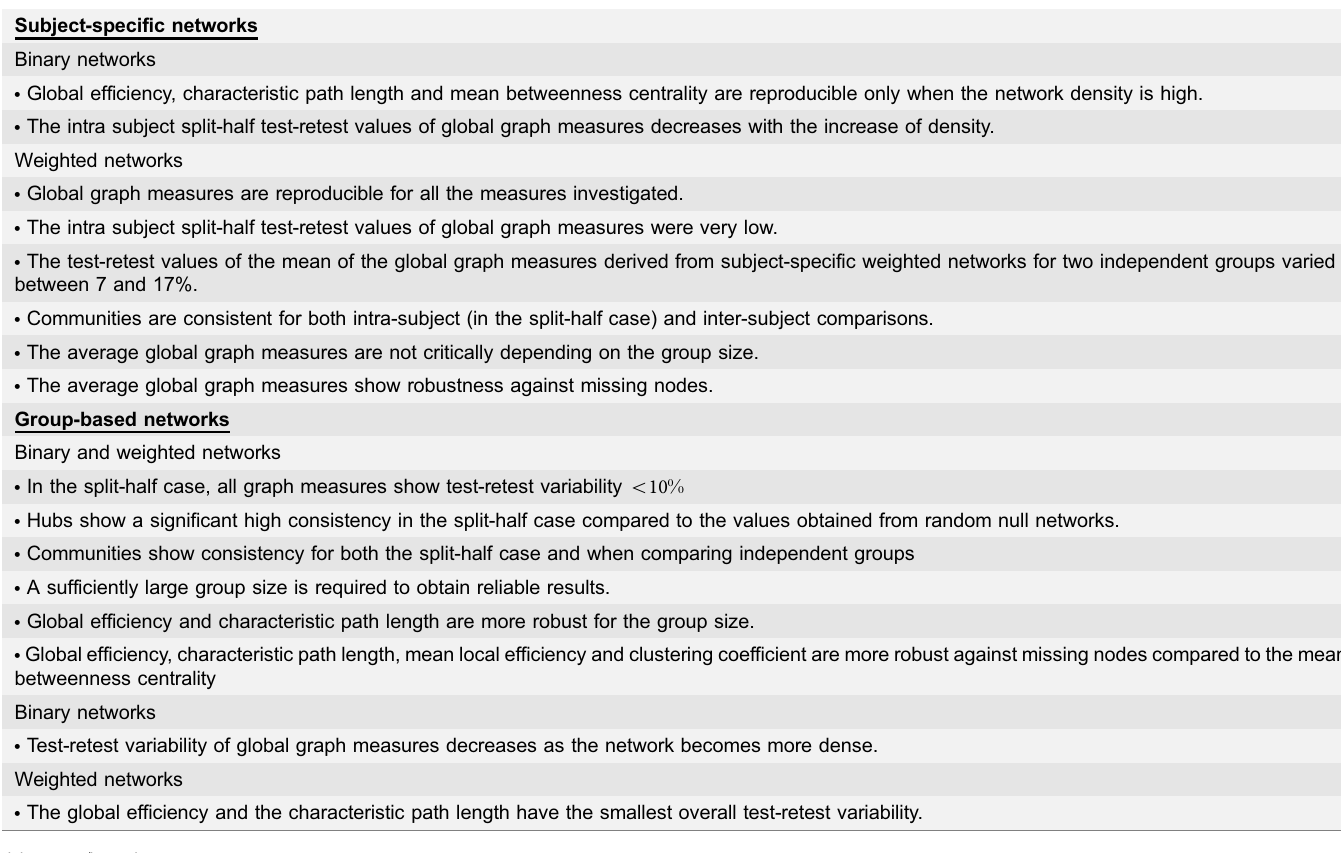
Table 1. Summary of the main